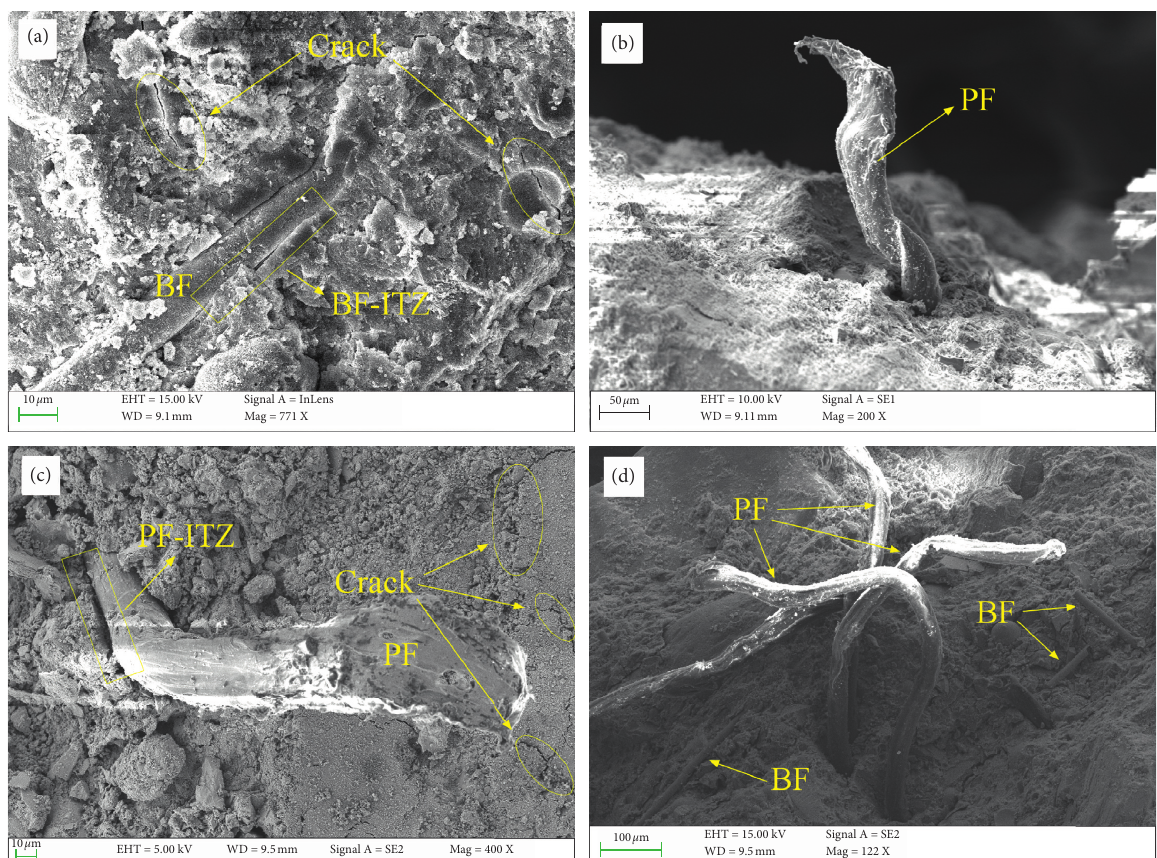
Figure 16: FE-SEM micrographs of BF and PF in BPFRC. (a) The interface between the BF and matrix. (b) Failure modes of PF. (c) The interface between the PF and matrix. (d) Distribution pattern of BF and PF with 0.2% hybrid